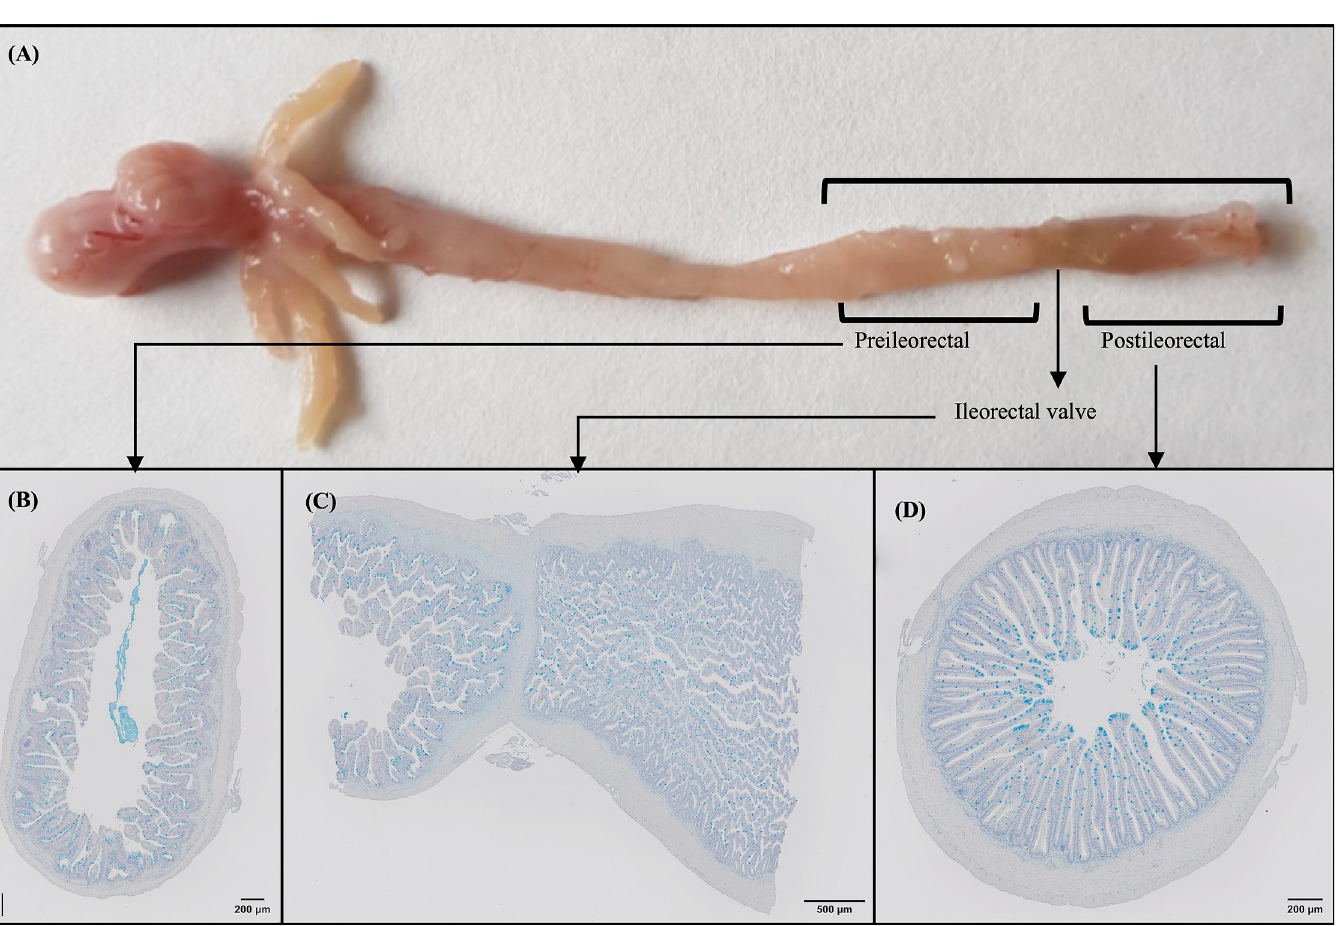
Fig 1. Nomenclature used for the gut segments used in this study. (A) Gut of European sea bass ( Dicentrarchus labrax ) juvenile, posterior gut (preileorectal valve segment) and rectum (postileorectal valve segment) regions sampled for morphological, morphometric, and immunohistochemical analyses. (B) Detailed micrograph of posterior gut stained with Alcian Blue (pH = 2.5); observe the shorter folds and higher density of goblet cells. Scale bar 200 μ m; (C) Detailed micrograph of the ileorectal valve separating European sea bass posterior gut and rectum. Scale bar 500 μ m. (D) Detailed micrograph of European sea bass rectum stained with Alcian Blue (pH = 2.5); observe the longer and thinner folds, the lower density of goblet cells, and the wider muscular layer. Scale bar 200 μ